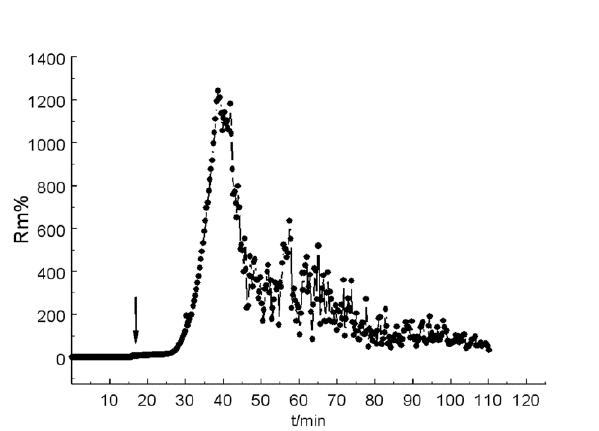
Fig. 5: Plot of the Rm% as a function of time using sucrose as the carbon source. The black arrow indicates the addition of sucrose.